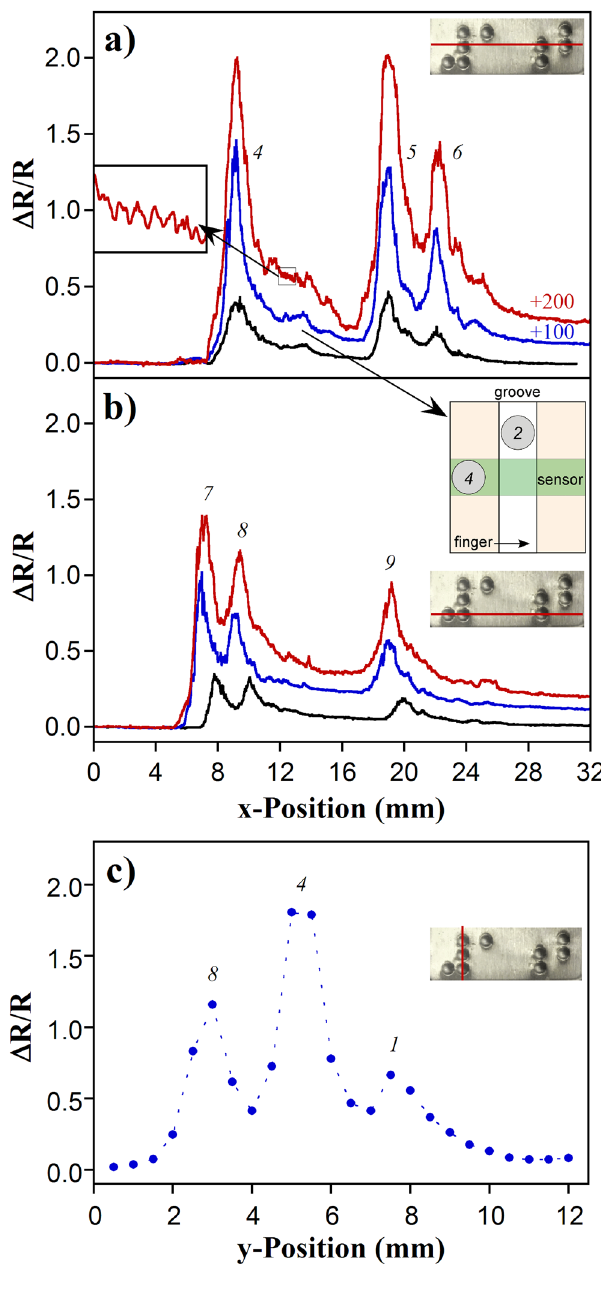
( a ) y = 5.25 mm (center row of dots) and ( b ) y = 2.75 mm (bottom row of dots). ( c ) Vertical line from the data in Fig. 6d at x = 8 mm (2 nd column of dots). (Positions are shown by red lines over the braille coupon here and as dashed lines in Fig. 6d. Dot numbers are shown in Fig.